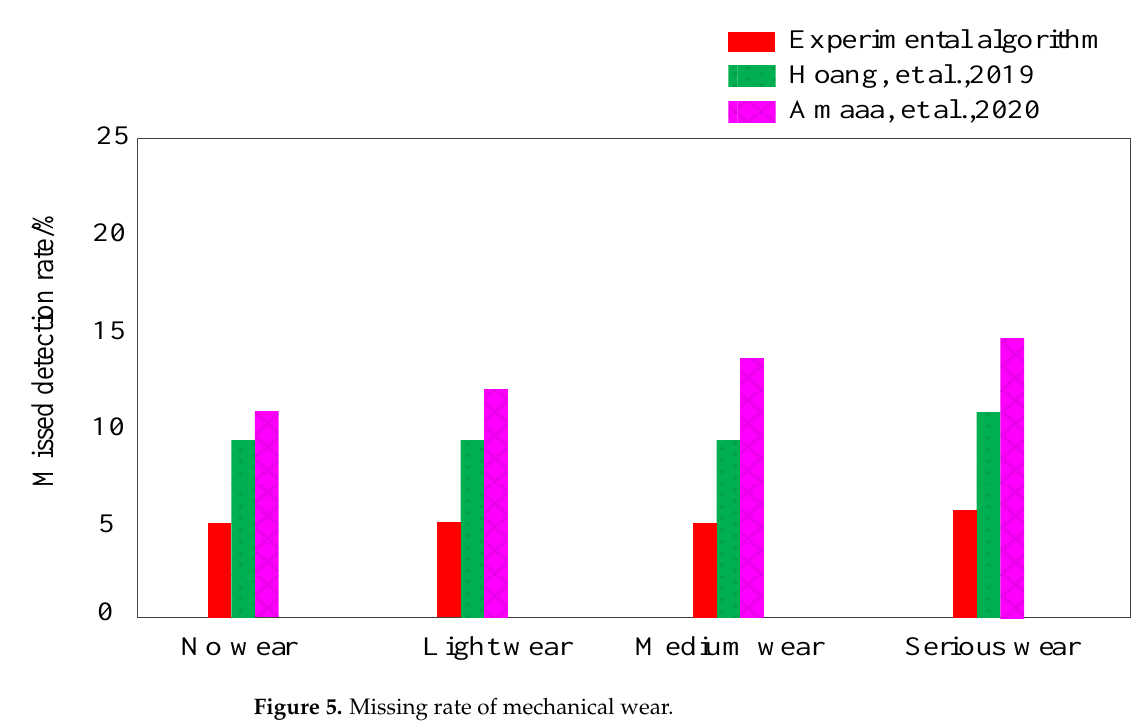
Figure 5. Missing rate of mechanical wear. It can be seen from the figure that the error detection rate and missed detection rate of mechanical wear detection based on the algorithm of Hoang. et al. [5] and Amaaa. et al. [6] were high, while the error detection rate and missed detection rate of mechanical wear detection using this experimental algorithm were low, and ideal mechanical wear detec- tion results could be obtained. This is because the experimental algorithm could better